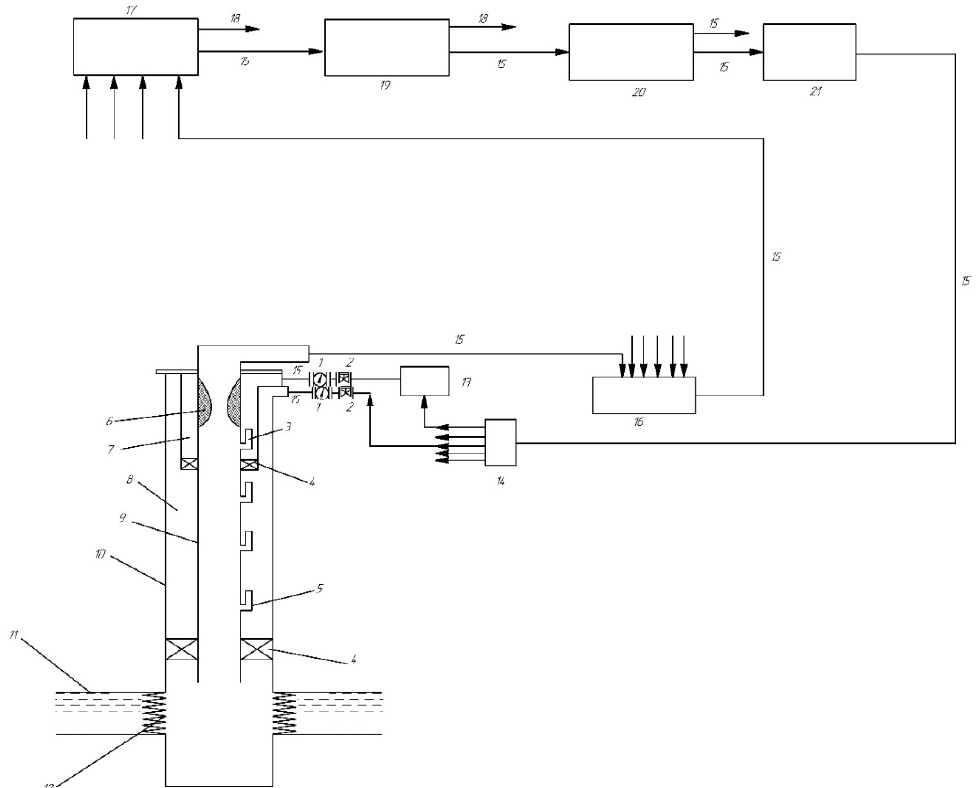
Figure 7. Implementation diagram of the proposed method for combating the wax formation in a gas lift well. 1—flow meter; 2—constant pressure valve; 3—gas-lift valve 3 for pumping heated APG; 4—packer; 5—working gas-lift valve; 6—asphaltene-resin-paraffin deposits (ARPD); 7—technological pipe; 8—annulus; 9—tubing strings; 10—casing string; 11—reservoir; 12—perforation interval; 13—APG heating unit; 14—gas distribution battery; 15—pipeline; 16—production manifold; 17—gas-oil separator; 18—oil enters the collector; 19—gas separator; 20—compressor station; 21—APG purification station from CO 2 and H 2